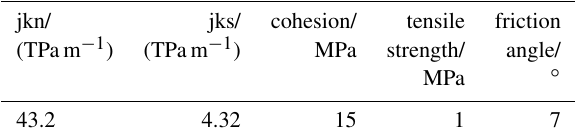
Table 8. Grain-scale contact parameters for rock mineral.